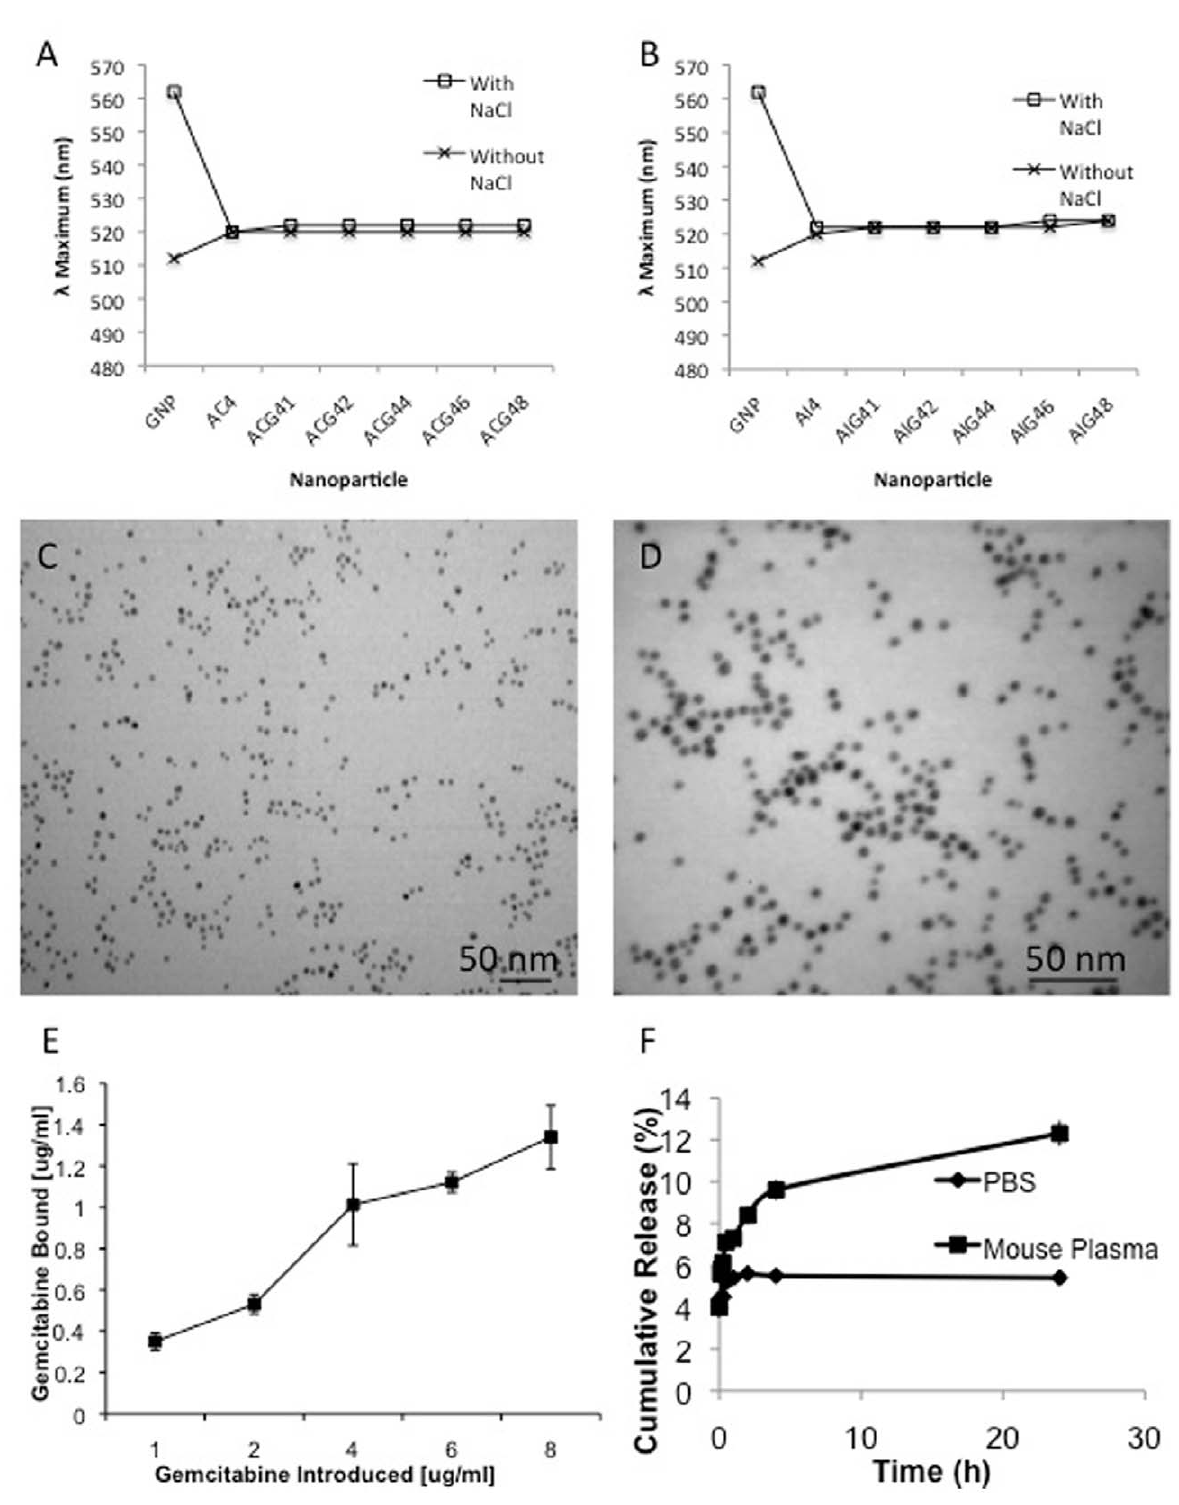
Figure 1. Physicochemical characterization of gold nanoconjugates. Figure 1A and 1B describes the changes in the l max value of GNP and different ACG44 and AIG44 nanoconjugates, respectively, with/without incubation with NaCl for 15 minutes. Figure 1C and 1D exhibits the transmission electron micrographs (TEM) of ACG44 and AIG44 nanoconjugates, drop coated after synthesis without alteration. Figure 1E describes the amount of gemcitabine bound to AC4 nanoconjugates analyzed by HPLC; the x-axis shows the m g/ml used to synthesize the conjugates and the y-axis represents the m g/ml bound to the particle. Figure 1F describes the release of gemcitabine from ACG44 nanoconjugates when incubated in PBS and mouse plasma over time.